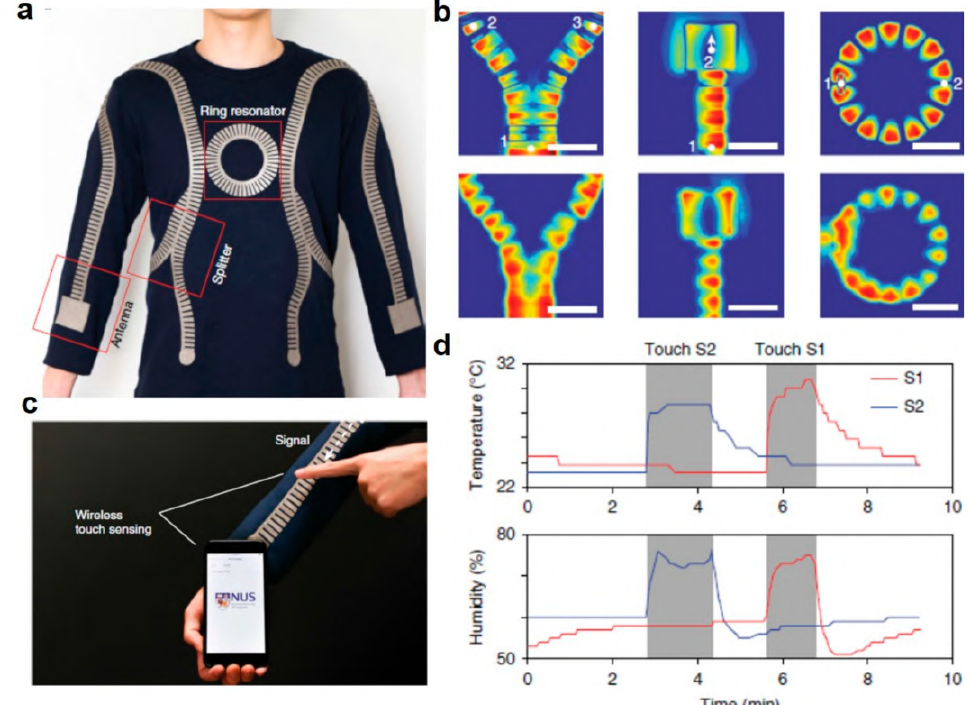
Figure 9. Wearable mechanical metamaterial textile for touching sensing. ( a ) Fabricated metamaterial textile with splitter, antennas and a ring resonator. ( b ) Simulation (top) and experiments (bottom) of the normal component of the electric field. ( c ) Metamaterial textile-based wireless touching sensing and ( d ) detected temperature and humidity signals when touching on shoulder (S1) and on wrist (S2), respectively. Reproduced with permission from [138]. Copyright 2019,